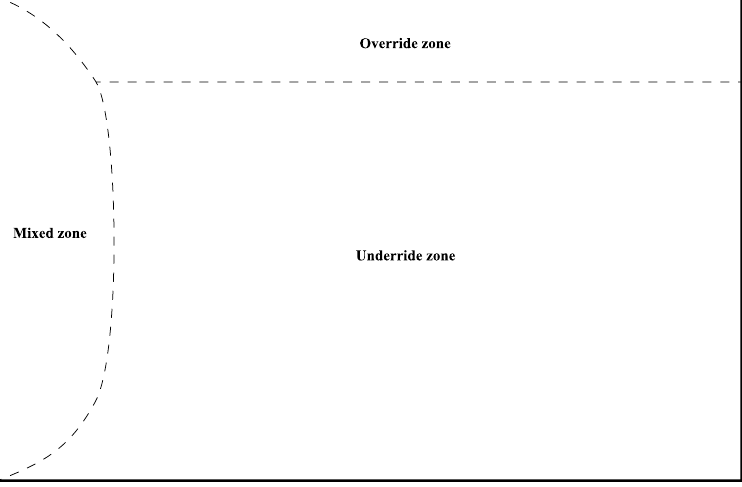
Figure 6. Flow zones in a porous medium during gas